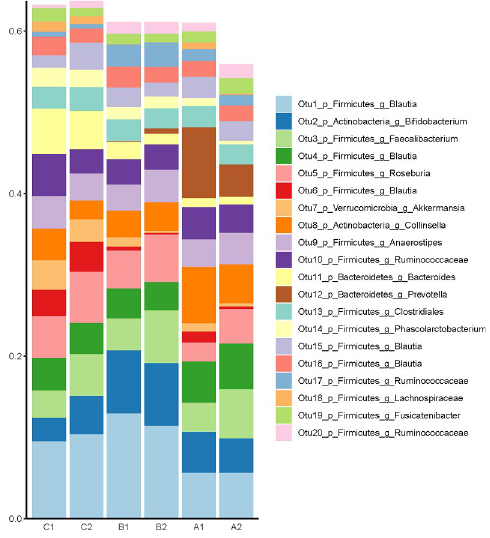
Fig 4. Top 20 OTUs (operational taxonomic units). OTUs are classified at the subgenus level and by relative abundance. OTU1 ( Blautia wexlerae ), OTU2 Bifidobacterium ( Bifidobacterium longum ), OTU3